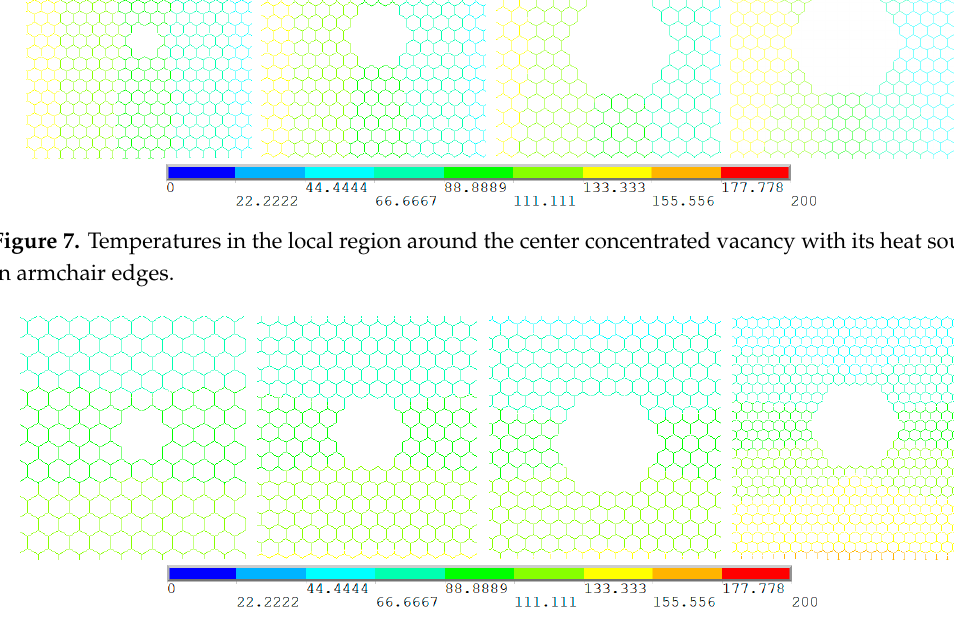
Figure 9. Periodic dispersion vacancy defects. ( a – d) for first-fourth mode of periodic vacancy defects.